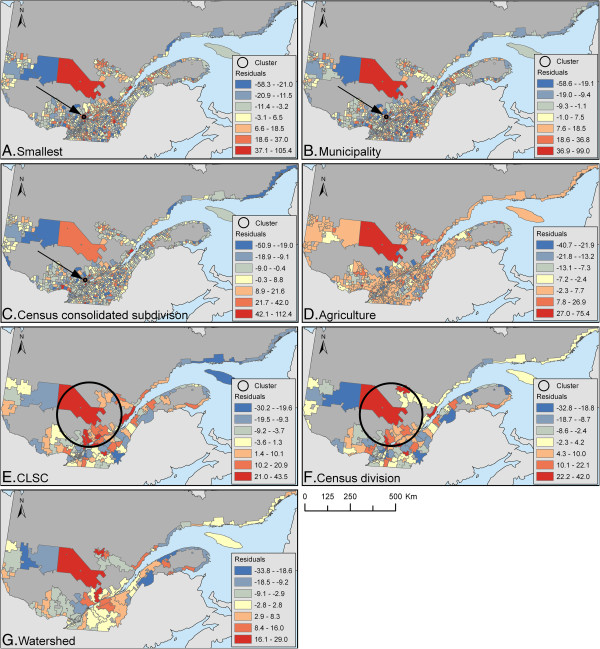
A-G. Distribution of residuals. Residuals from a CAR model predicting the annual incidence of reported cases of campylobacteriosis per 100,000 people in Quebec (1996–2006) according to various geographical units. Significant clusters (p<0.05) in residuals according to the scan test are illustrated. Classification was done using Jenk’s natural breaks. Dark grey areas represent the unpopulated areas, non-organized territories or incompletely enumerated Indian reserves and settlements within Quebec, whereas light grey shows the frontier area of Quebec.